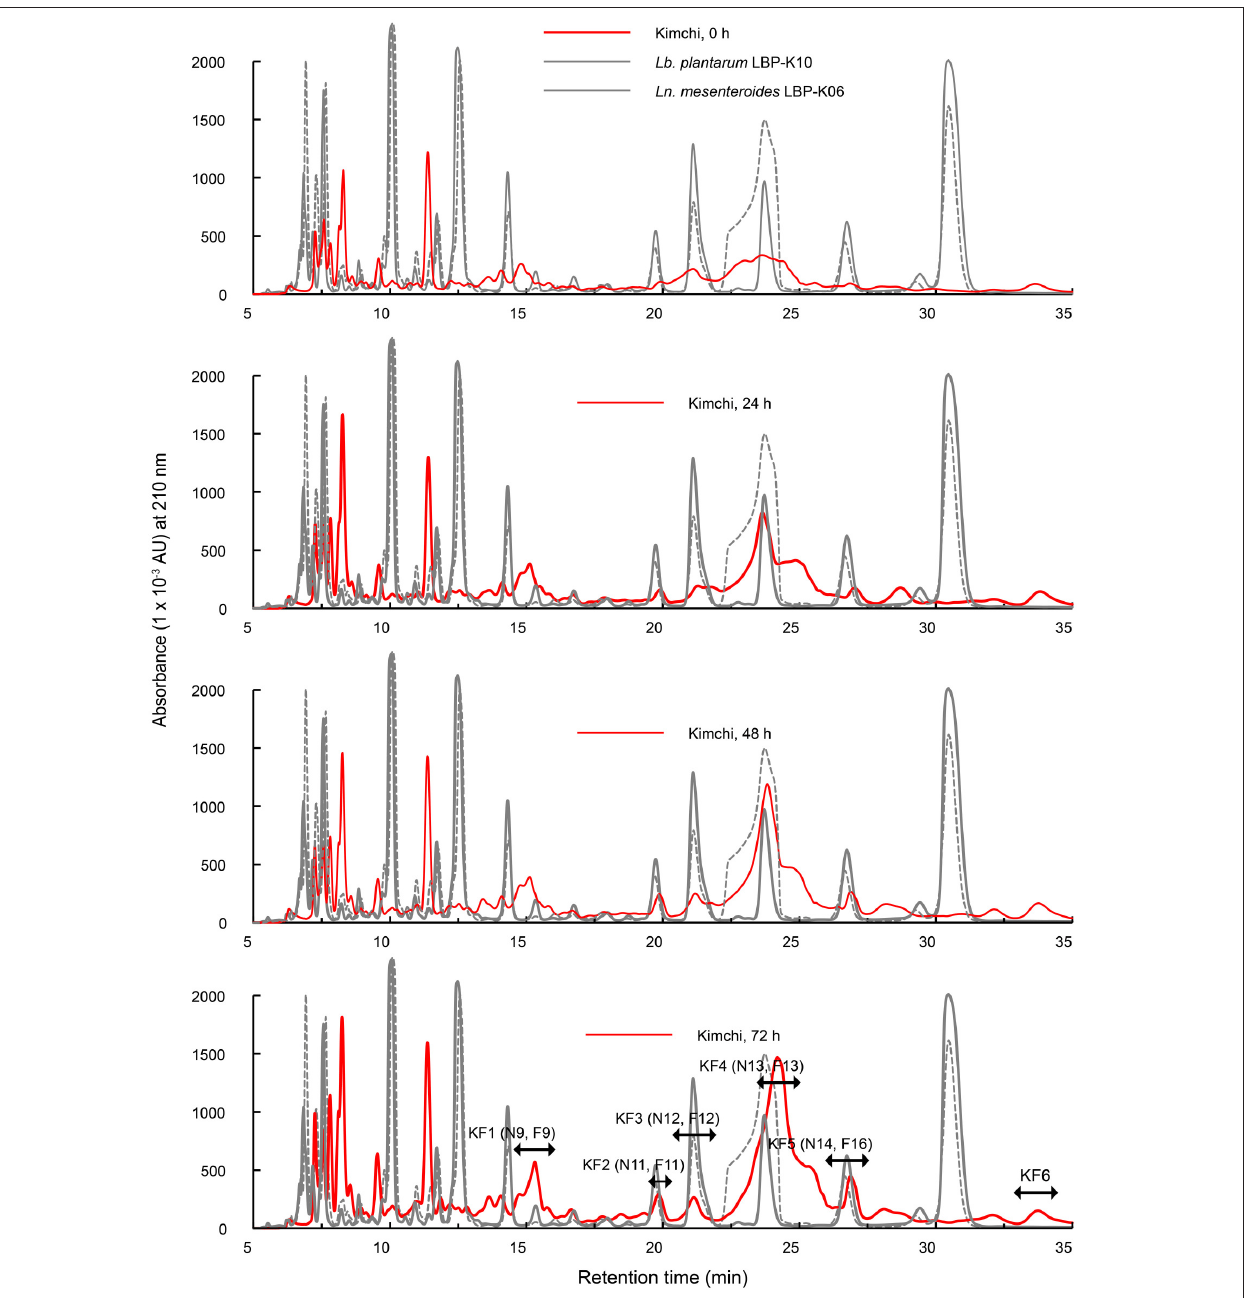
FIGURE 4 | Comparisons of the chromatograms of kimchi filtrates obtained from Chinese cabbage kimchi inoculated with Ln. mesenteroides LBP-K06. Chinese cabbage kimchi was further incubated for 72 h at 25 ◦ C after the initial kimchi-fermentation stage. A chromatographic separation of kimchi filtrates was performed at a wavelength of 210 nm. Each experiment was performed at least three times